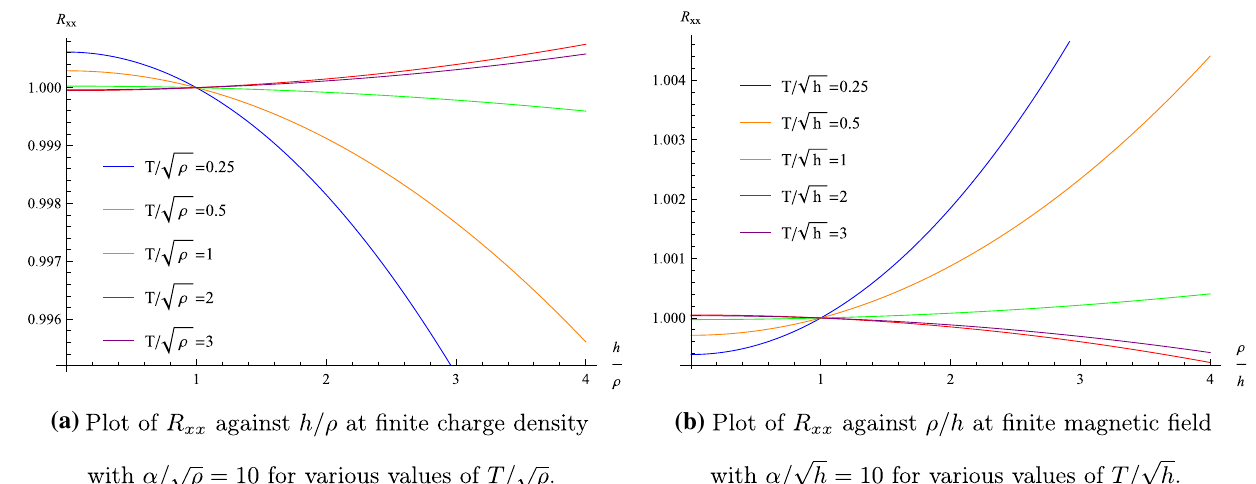
Fig. 9 Plots of how the dependences of R xx on ρ and h change with respect to T . Here we consider Born-Infeld electrodynamics with a = −